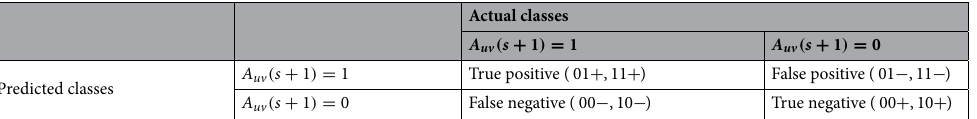
Table 3. The Confusion matrix for the prediction of edges between nodes u and v in the next snapshot, ( s + 1 ) . The adjacency matrix at snapshot s in the temporal network is A ( s ) . Each of the four outcomes comes from two situations as this confusion matrix does not consider the state of the edge in snapshot G ( s ) . The two states are shown for each of outcome in brackets with the notation that αβ ± shows the value of A uv ( s ) as α , the predicted A uv ( s + 1 ) as β , and a + symbol (a − symbol) indicates that the prediction made was correct